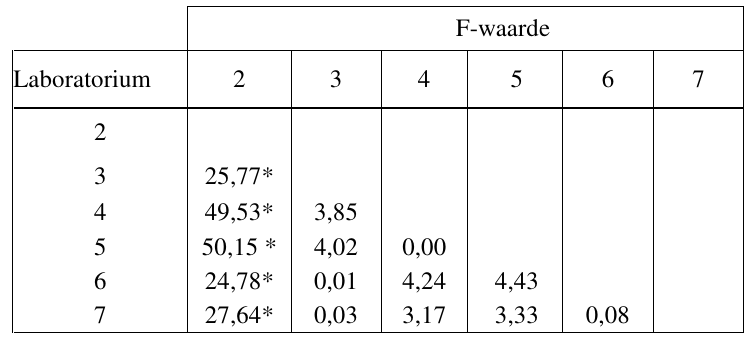
VERSKILLE TUSSEN GELYKE LUIDHEIDSWAARDES OP DIE 75